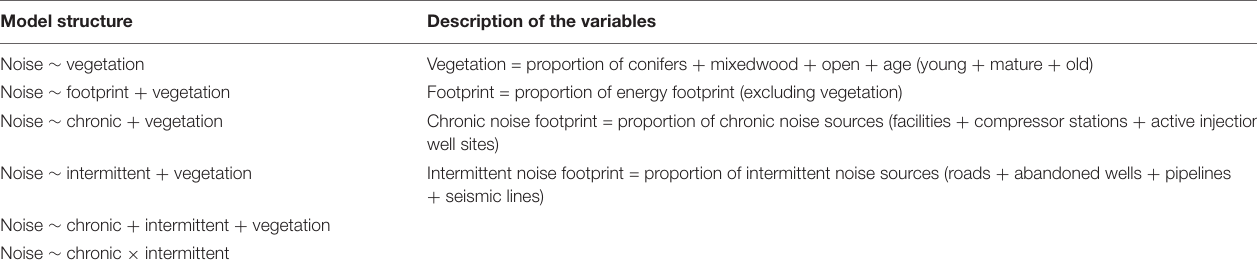
TABLE 1 | Model structure and description of the variables included in the respective model to test the noise hypotheses. Model